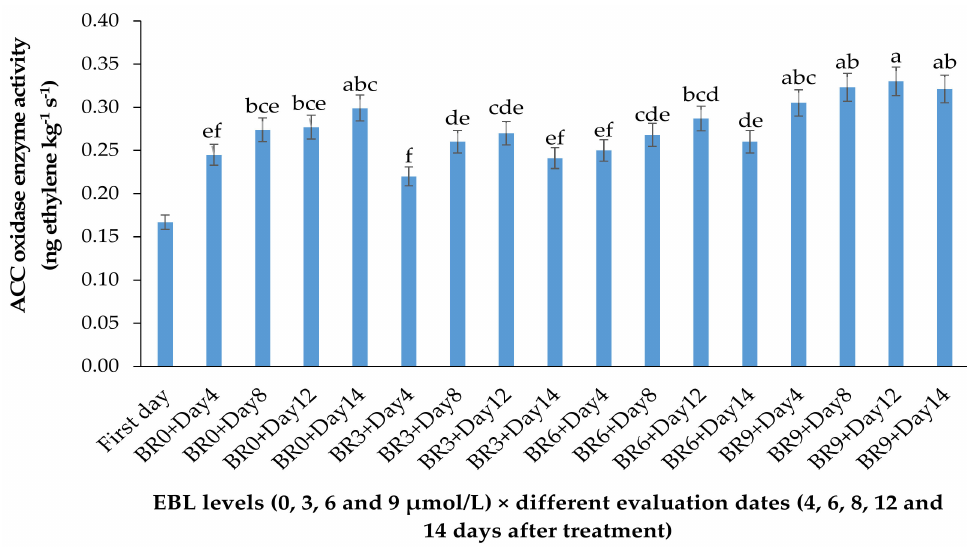
Figure 2. Effect of different concentrations of EBL on ACC oxidase activity of lisianthus cut flowers during 14 days of storage. Error bars represent the standard error of means of four replicates. Columns indicated by different letters are significantly different according to Duncan’s multiple range test ( p ≤ 0.01). The first day is the harvest time of samples.